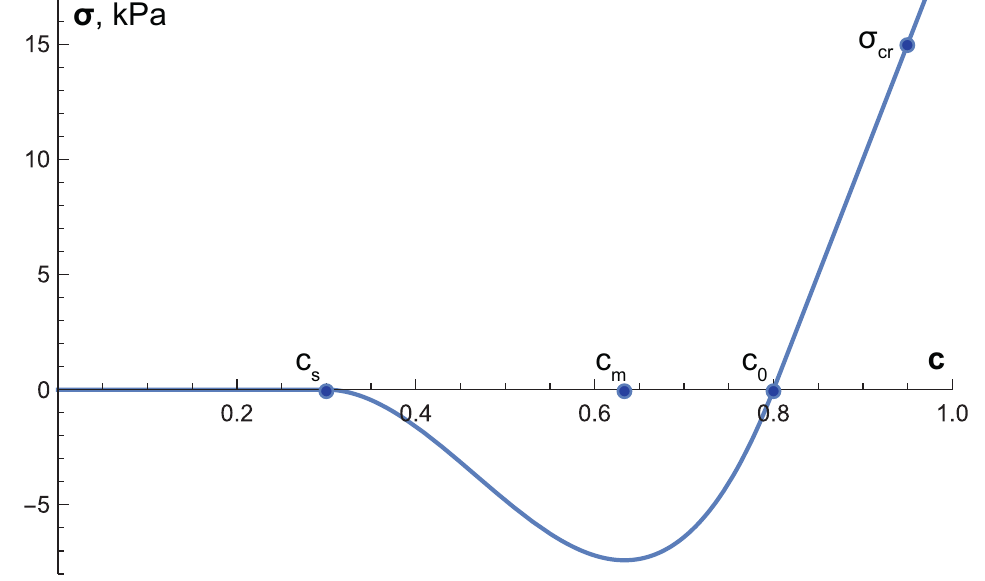
Figure 1. Dependence of solid stress σ on cell fraction c , used in Equation (6). If cell fraction is greater than its normal value c 0 , the repulsive interaction appears. If c < c 0 , the adhesive interaction at first strengthens and then weakens with the decrease of cell fraction. For sufficiently sparsely distributed cells at c < c s there is no interaction between them. The parameter values are based on the basic parameter set, listed below in Table 1. c m ≡ [ 2 c 0 + c s ] /3 is the cell fraction at which solid stress is